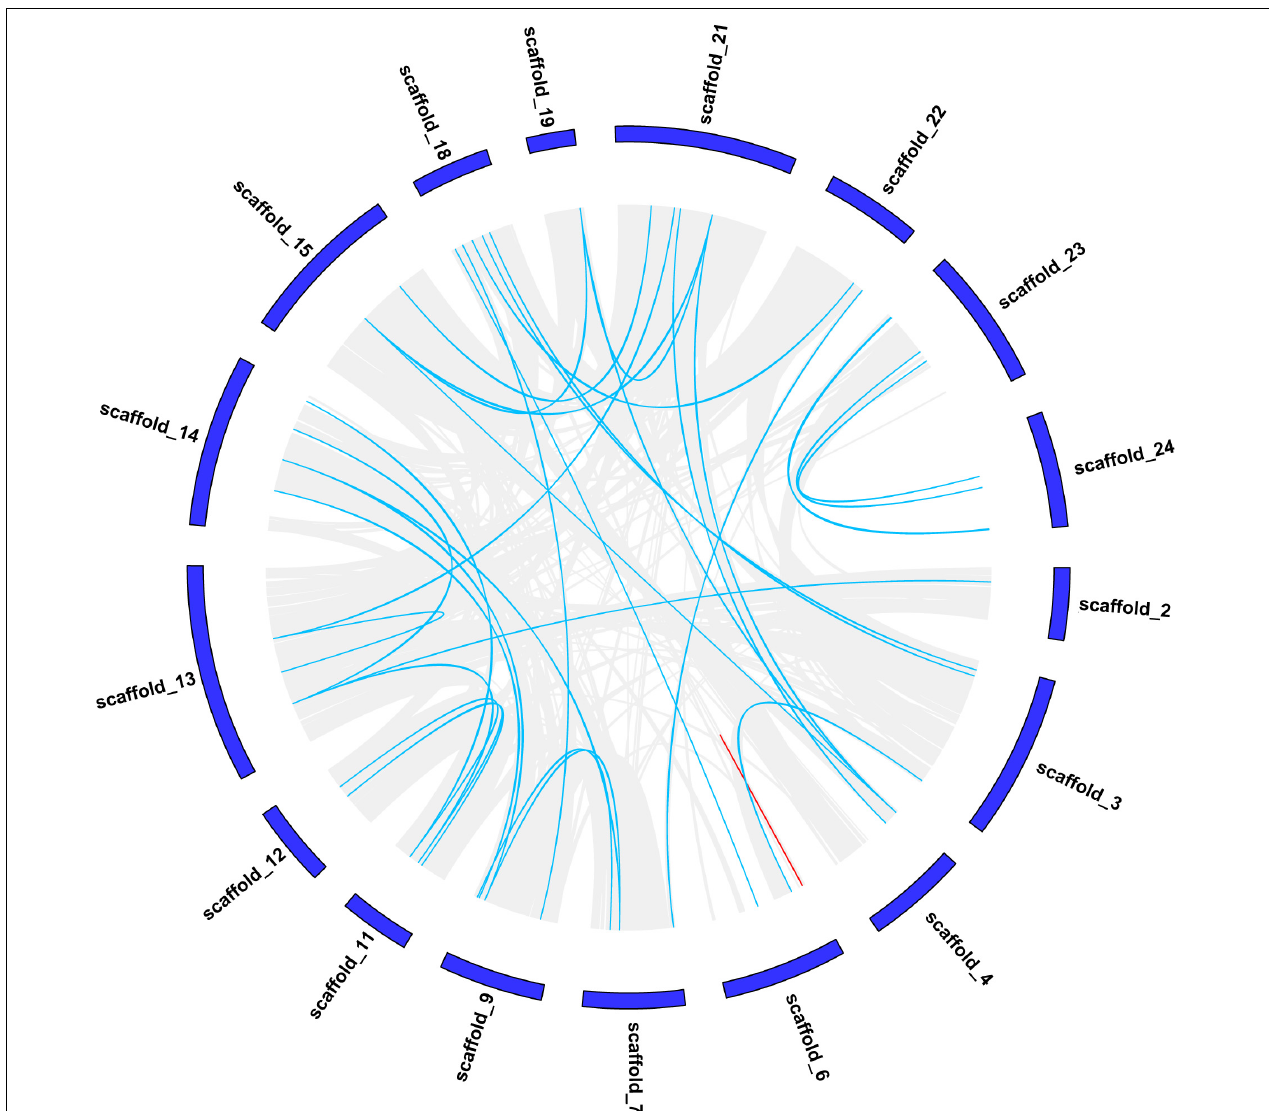
FIGURE 2 | Chromosomal localizations and duplications of CCCH genes on moso bamboo chromosomes. The duplicated CCCH genes are indicated with blue lines and tandemly duplicated genes are marked with red.